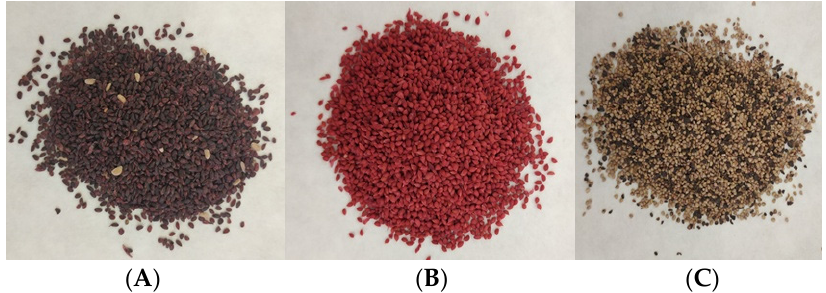
Figure 1. Black currant ( A ), cranberry ( B ) and strawberry ( C )